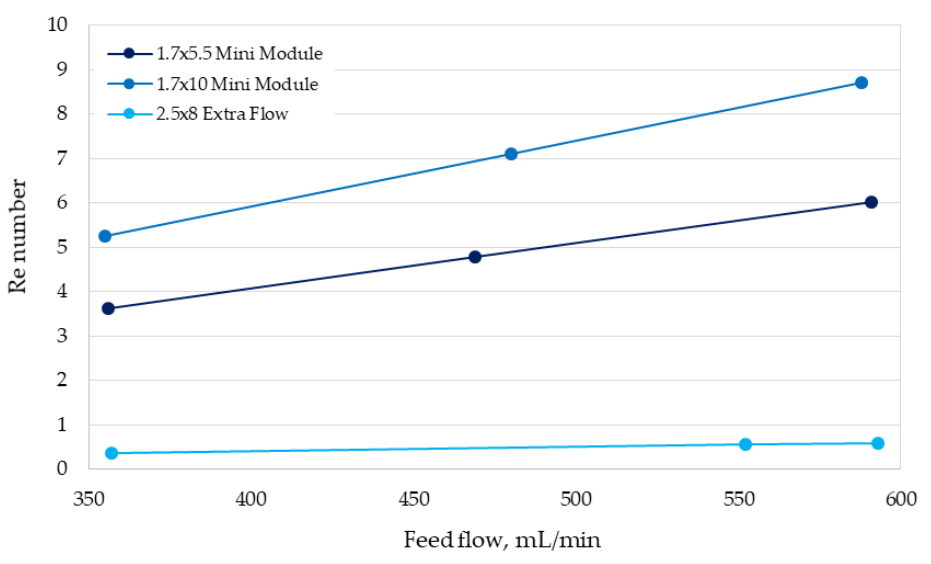
Figure 5. Values of the Reynolds number (Re) for each HFMC module with respect to the feed flow.